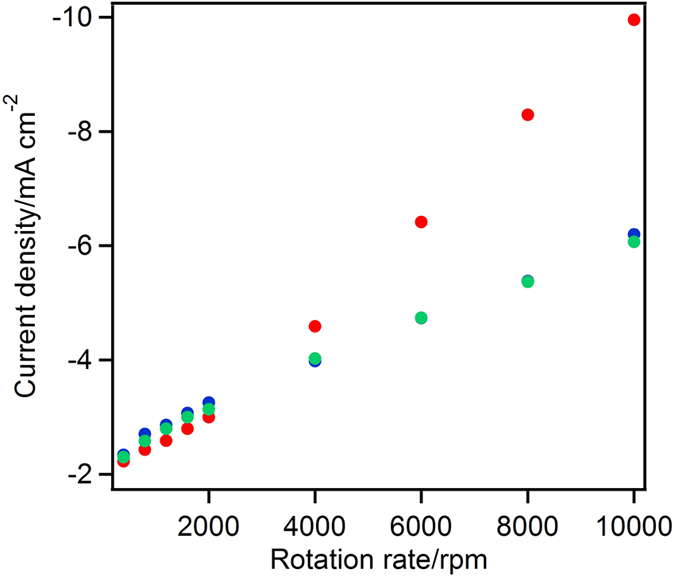
Rotation rate dependence of the current density. MgOCmacro (green), MgOC33 (red), and MgOCmeso (blue).